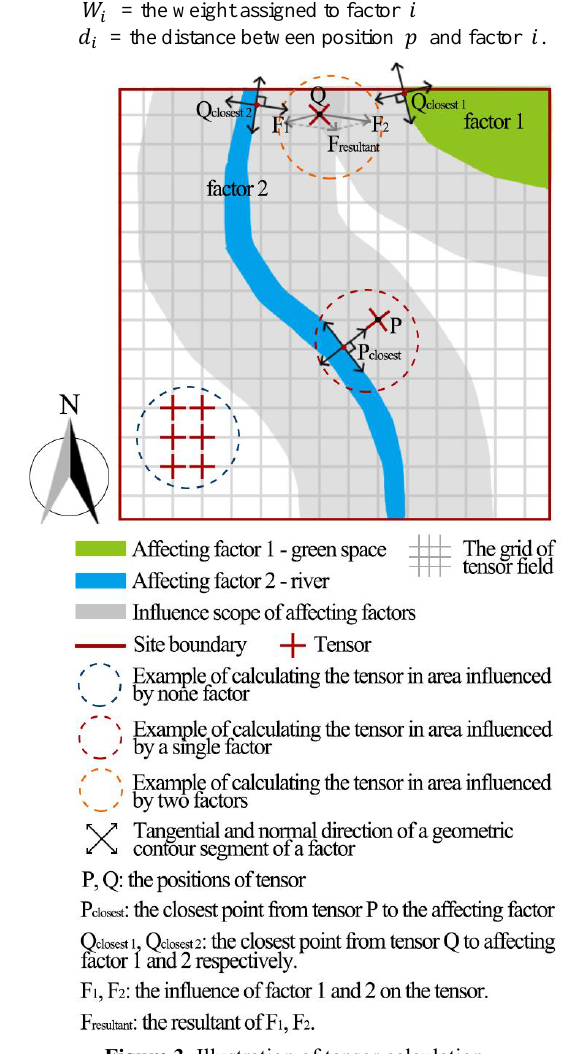
Figure 3. Illustration of tensor calculation